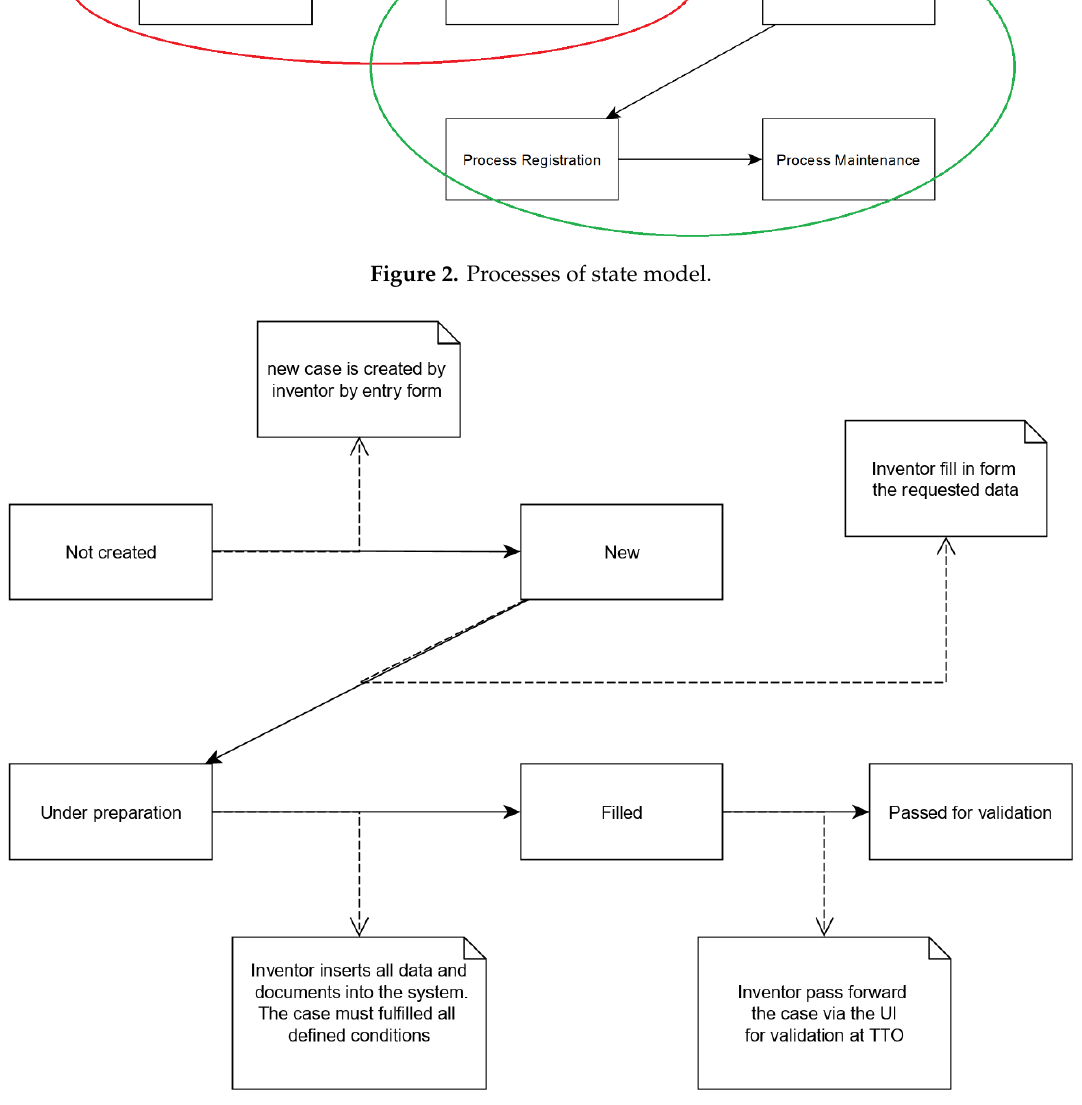
Figure 3. States of process “Process—Creation”.